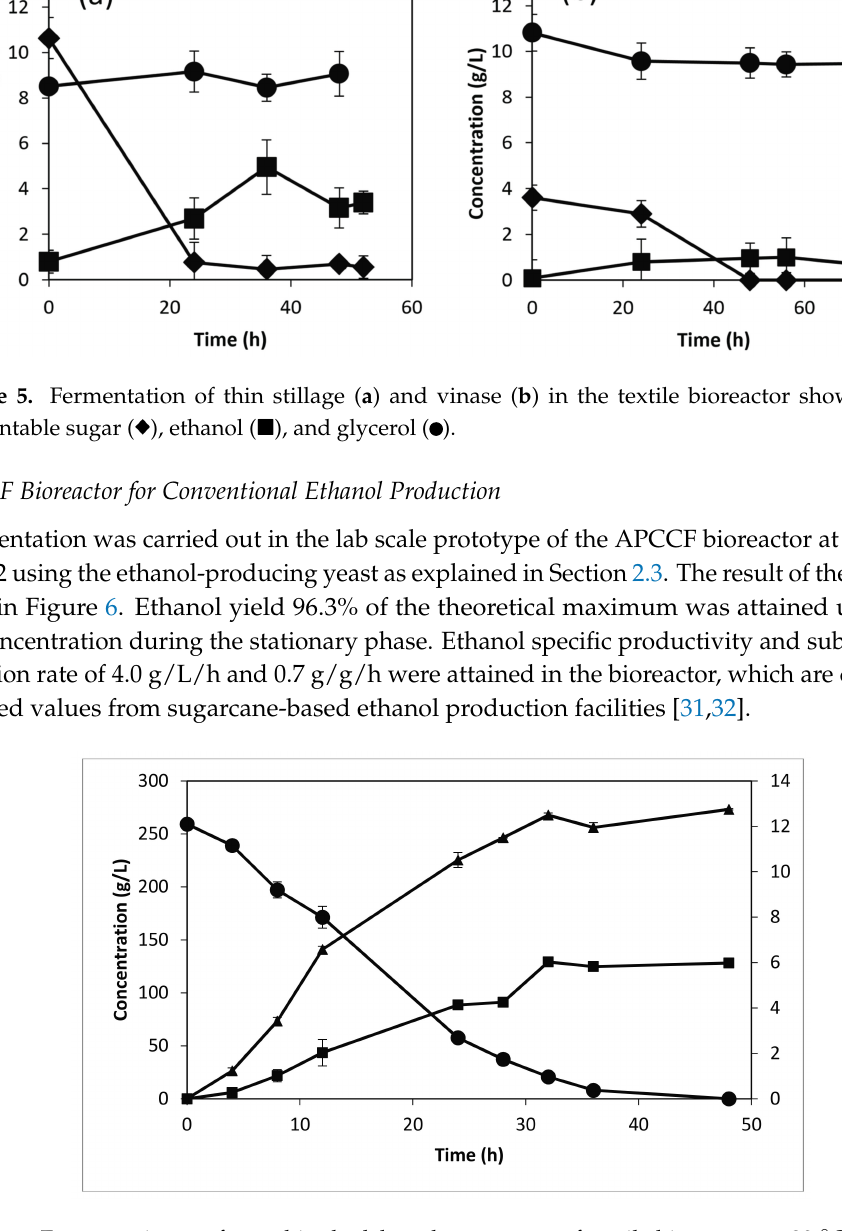
Figure 6. Fermentation performed in the lab scale prototype of textile bioreactor at 30 ◦ C showing sucrose ( ), ethanol ( (cid:4) ) in the primary axis and glycerol ( (cid:78) ) in the secondary